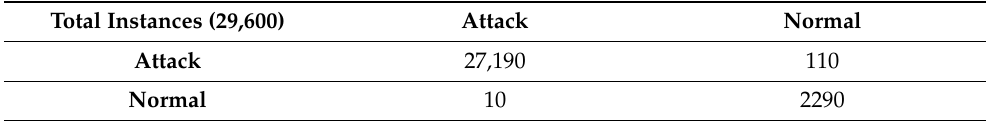
Table 3. Training confusion matrix of SVM.